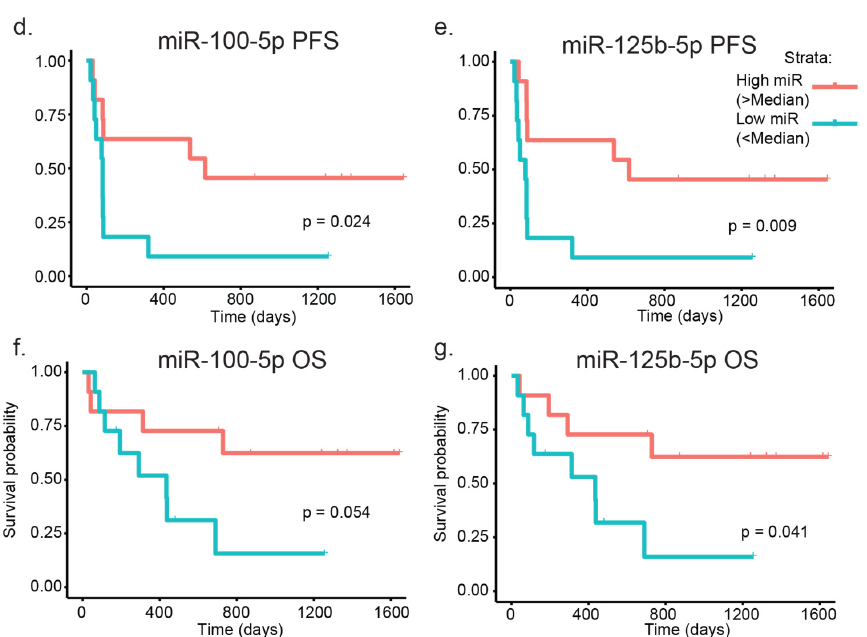
Figure 3. Survival analysis of melanoma microRNAs in pre-PD-1-inhibitor treated melanoma biopsies. MicroRNA sequencing was performed on 22 pre-PD-1-inhibitor-treated melanoma biopsies, and log2-transformed vst counts were generated using DESEq2. ( a ) Forest plot displaying hazard ratios ± 95% confidence intervals, from a univariate Cox’s proportional hazard analysis of each of the 19 microRNAs with the highest degree centrality in the bipartite network analysis of TCGA microRNA–mRNA expression. ( b , c ) Boxplots comparing variance-stabilised-log2-transformed counts of miR-100-5p and miR-125b-5p in melanoma biopsies from patients who did not receive clinical benefit from anti-PD-1 immunotherapy versus those who did receive clinical benefit. Boxplots display median, interquartile range and whiskers representing 1.5 times the interquartile range. ( d – g ) Kaplan Meier curves displaying the time to PFS or OS for patients with biopsies, with high (above median) compared to low (below median) expression of miR-100-5p or miR-125b-5p. p -values represent log-rank